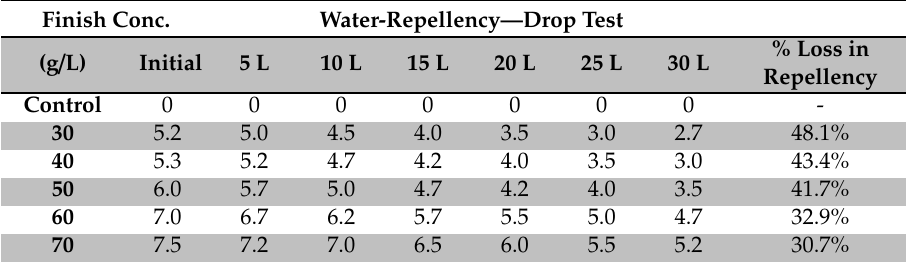
Table 1. E ff ect of laundering on Water-repellency (drop test) of polyester / cotton. Finish Conc.